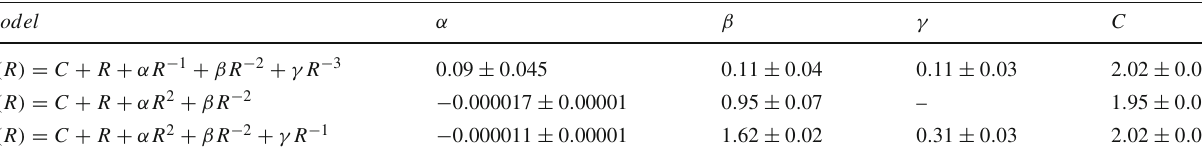
Table 3 Form of the f ( R ) theory and obtained constraints for the model parameters when H 0 = 67 . 40 ± 0 . 5 km s − 1 Mpc − 1 has been merged to the expansion rate data used in the GP. The constraints are for the three models given in Eqs. (18), (20) and (21), respectively Model